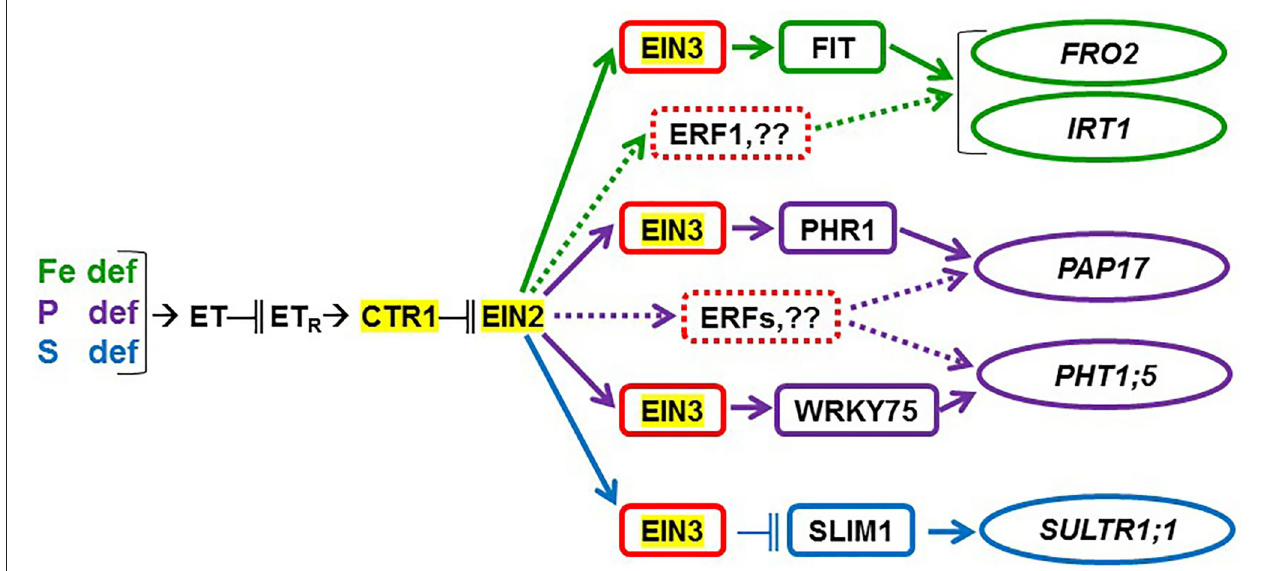
FIGURE 12 | Possible participation of ethylene, through CTR1, EIN2, and EIN3/EIL1, in the regulation of the Fe-, P-, and S-related genes considered in this study. Ethylene (ET) production is enhanced in Fe-, P-, and S-deficient roots. ET then acts in a signaling pathway which includes ET receptors (ET R ) and the CTR1 and EIN2 proteins. This latter one can act through the EIN3/EIL1 TFs (represented as EIN3 in the figure), which have been implicated in the regulation of the FIT, PHR1, WRKY75, and SLIM1 TFs controlling the activation of Fe-, P-, and S-related genes, like FRO2 , IRT1 , PAP17 , PHT1;5 , and SULTR1;1 (see text for details). Results in this work suggest that the EIN2 protein plays a key role in the regulation of the physiological responses to the three deficiencies and in the crosstalk between them. Moreover, the results support that TFs in addition to EIN3/EIL1, like ERF1 and other ERFs, could participate in the upregulation of Fe- and P-related genes (dotted lines). In red, ET-related TFs; in green, Fe-related TF and genes; in purple, P-related TFs and genes; in blue, S-related TF and gene. “ → ” promotion; “ −k ”